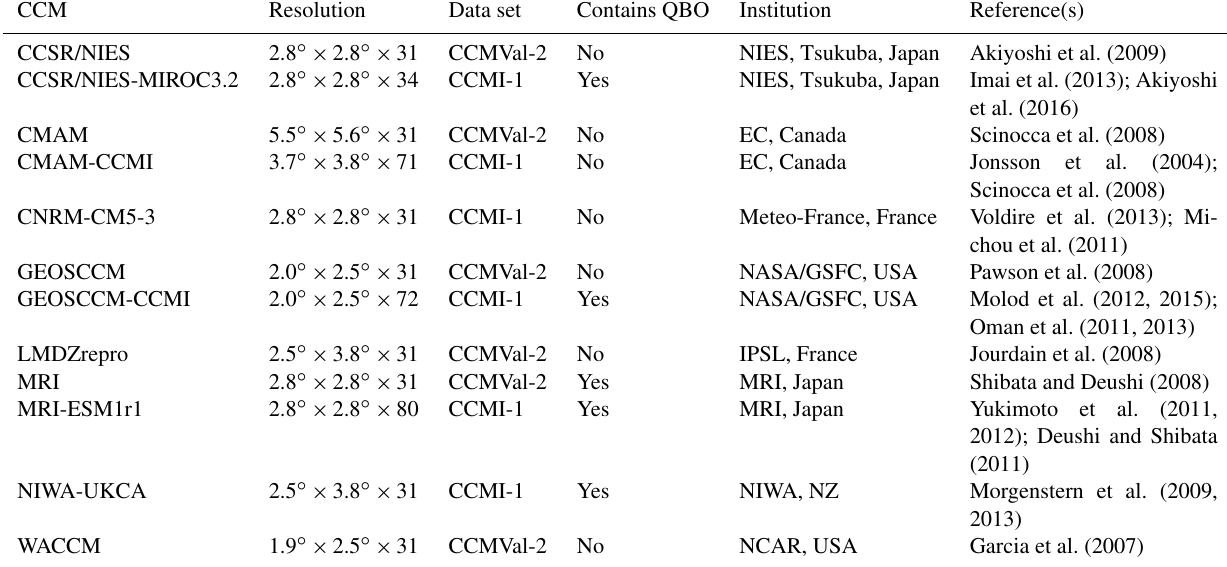
Table 1. Chemistry–climate models (CCMs) used in this analysis. The resolution is listed as (lat × long × number of pressure levels). Thirty-one vertical levels indicates CCM data is given on isobaric levels, while CCMs simulating data on > 31 levels are given on sigma (hybrid-pressure) levels. Abbreviations are as follows: quasi-biennial oscillation (QBO); Center for Climate System Research/National In- stitute for Environmental Studies (CCSR/NIES); Model for Interdisciplinary Research on Climate (MIROC); Canadian Middle Atmosphere Model (CMAM); Chemistry-Climate Model Initiative; Centre National de Recherches Météorologiques (CNRM); Goddard Earth Observing ical Research Institute (MRI); National Institute of Water and Atmospheric Research (NIWA); United Kingdom Chemistry and